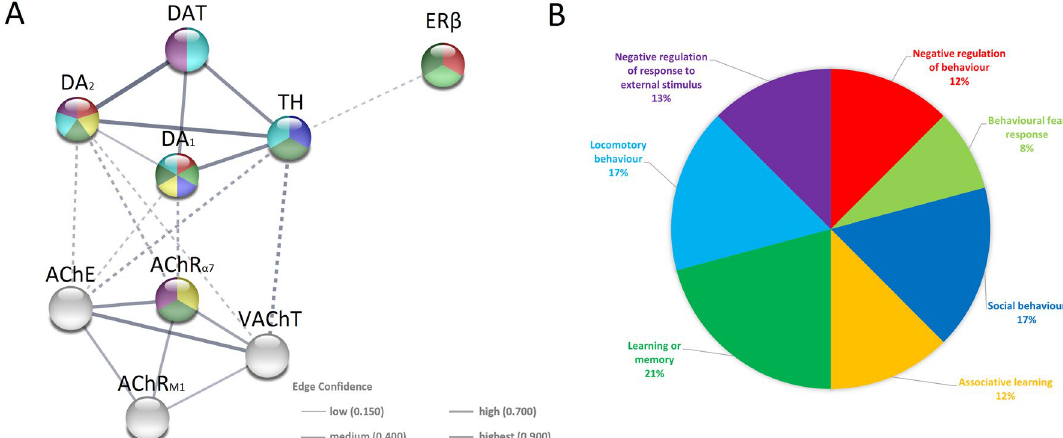
Figure 9. Protein–protein interaction (PPI) networks of potential targets by STRING database ( Mus musculus ). ( A ) PPI network of 9 potential targets, contains 9 nodes (proteins) and 20 edges (protein–protein associations). Dotted lines represent edges among 3 clusters (dopaminergic, cholinergic, and oestrogenic). The thickness of the line is proportional to the edge confidence. ( B ) Pie chart of term associated with emotional behaviour. Each colour represents a particular biological process; please note that studied markers are involved in these processes ( A